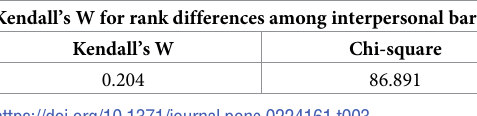
Table 3. Descriptive statistics (interpersonal barriers).